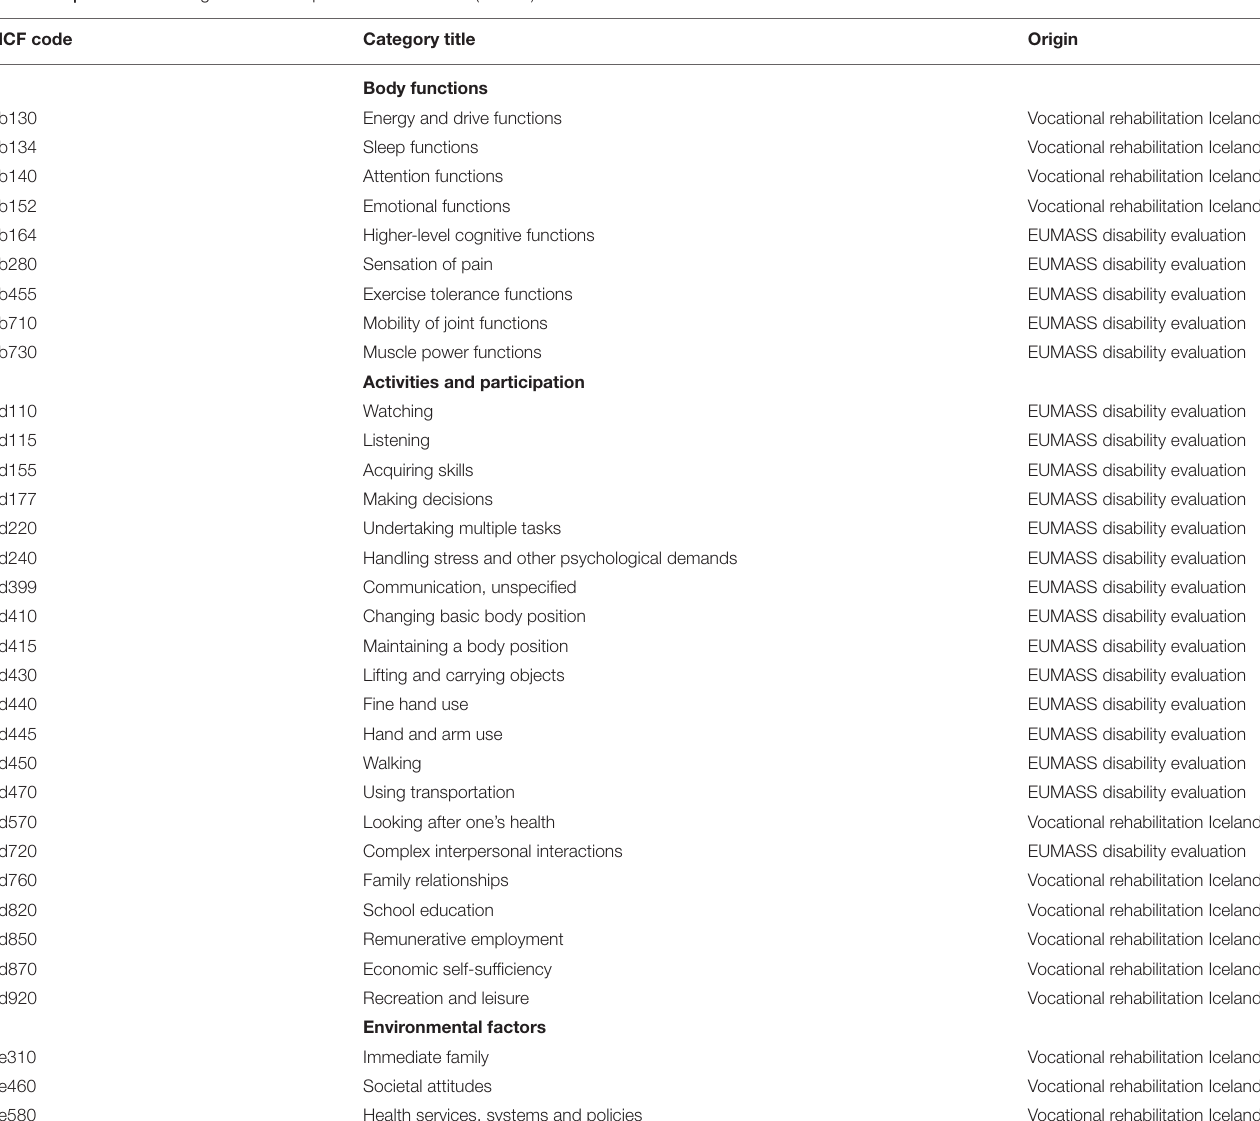
TABLE 2 | ICF subset categories for occupational rehabilitation ( n =